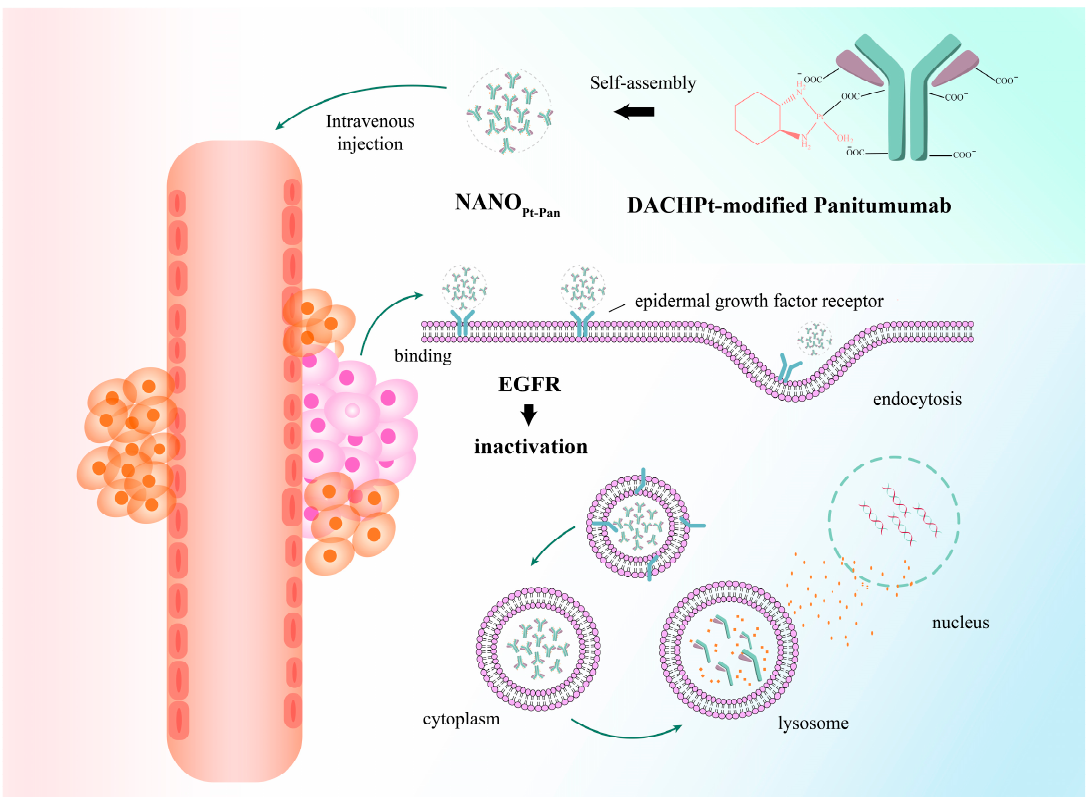
Figure 3. Scheme of nanoparticulate Pt-based drug delivery system to upgrade intracellular accumulation. Nanoparticles prevent drug degradation and reduce toxic side effects by delivering the right dose of the drug at the right time and to the right target. Due to the specificity of nanoparticles, researchers are focusing on combining them with Pt-based drugs in order to achieve targeted delivery and increase the accumulation of drugs in tumor cells to achieve the desired efficacy. Reprinted with permission from Ref.